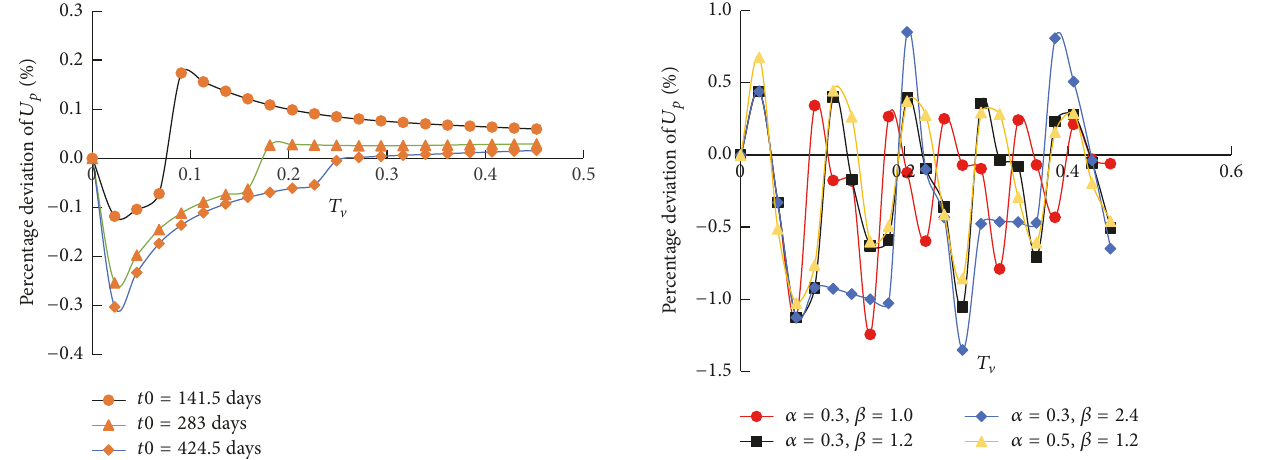
Figure 7: Percentage deviation of 𝑈 𝑝 between the FAM and the semianalytical solution versus 𝑇 V curves for single ramp loading.